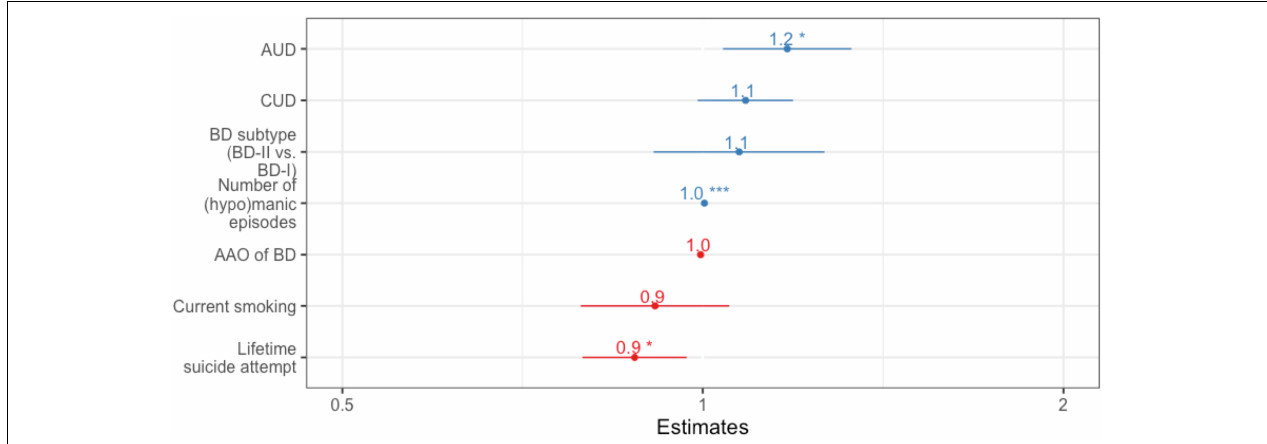
FIGURE 3 | Forest plot for binary logistic regression in Norway, with “being unmedicated vs. medicated” as the dependent variable. N = 195 after exclusion of first-episode cases. Bar length indicates 95% confidence interval. AAO, age at onset; BD, bipolar disorder; AUD, alcohol use disorder; CUD, cannabis use